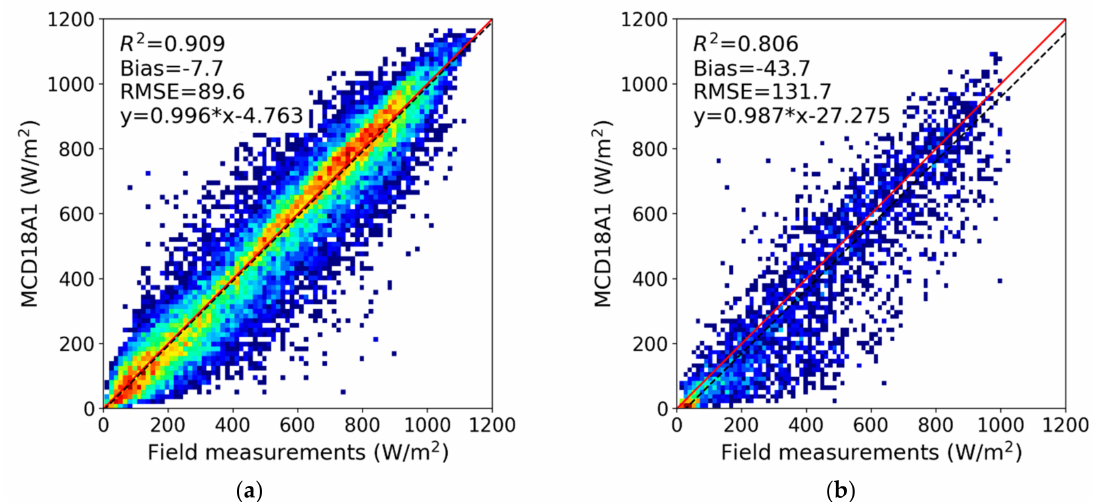
Figure 4. Validation results of the MCD18A1 DSR product with two di ff erent inputs of surface reflectance: ( a ) MCD43A3 product and ( b ) surface reflectance